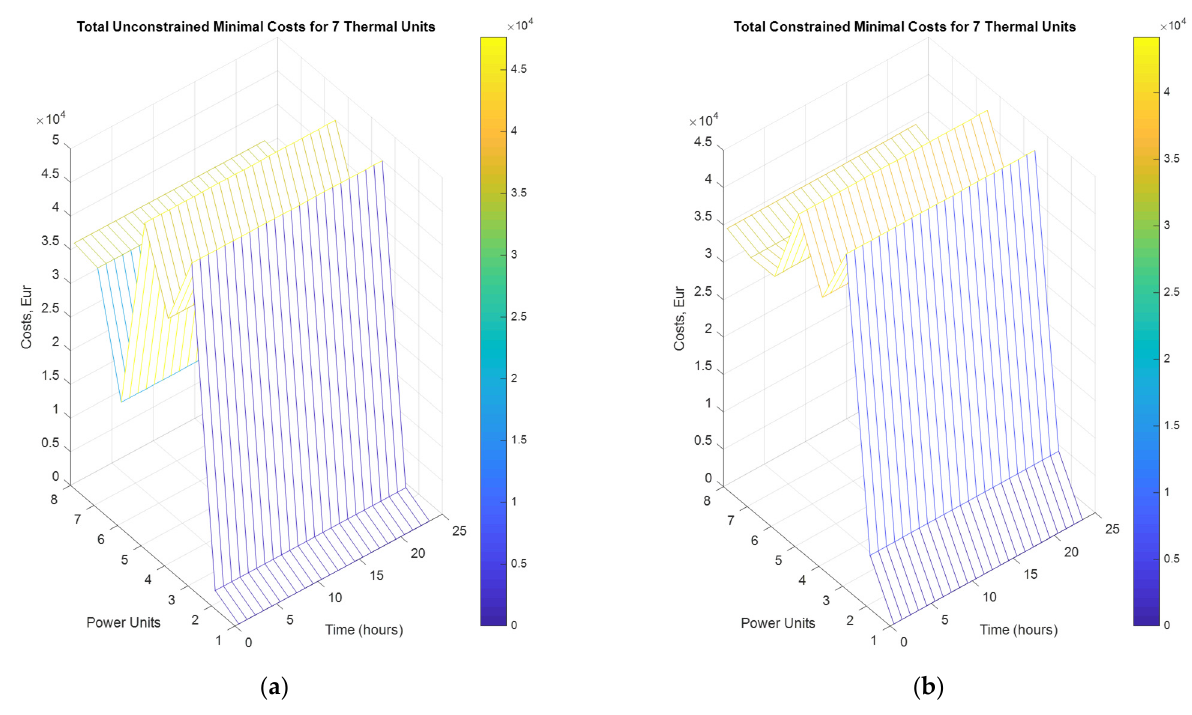
Figure 7. ( a ) Scenario 2: Total unconstrained minimal costs of seven thermal units over 24 h (CSP disabled); ( b ) Scenario 2: Total constrained minimal costs of seven thermal units over 24 h (CSP disabled).